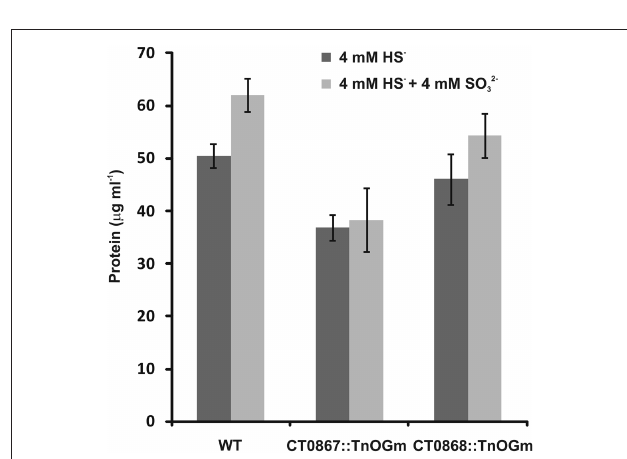
FiGurE 4 | A comparison of sulfite addition to wild type and mutant C. tepidum strains. Strains were grown in batch cultures containing sulfide-only (dark bars) or sulfide + sulfite (light bars) as electron donors for photosynthesis. The protein concentration was determined in stationary phase for three independent cultures for each condition and strain. The data are the means ± SE.